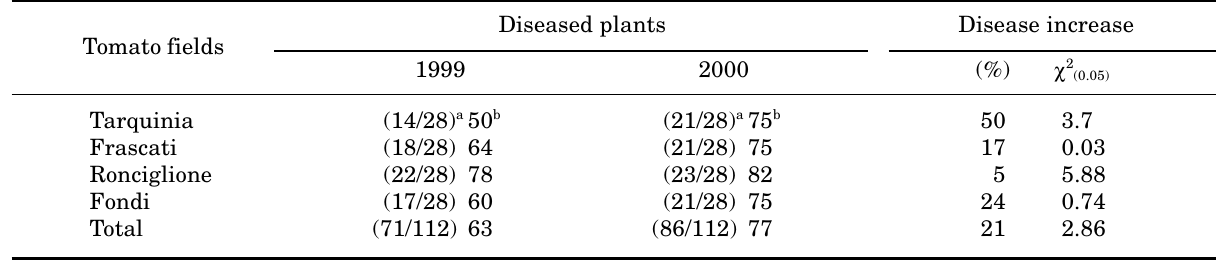
Table 1. Incidence of phytoplasma disease in four fields in Latium, Italy, in 1999 and 2000.